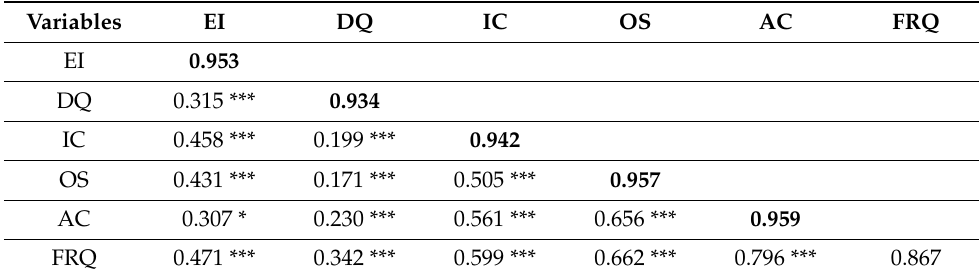
Table 4. Constructs Correlation for the overall measurement